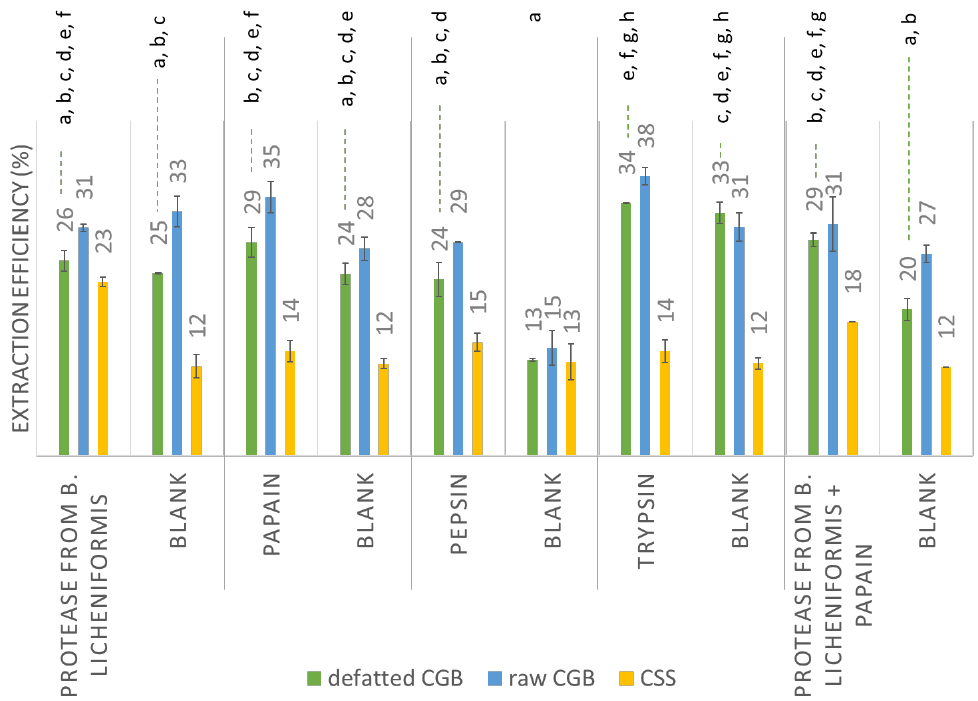
Figure 3. Extraction efficiency of aqueous extraction (blank) and enzyme-assisted extraction on coffee by-products. The extraction efficiency of the water extraction was measured under the same pH and temperature conditions of the respective EAE. The same letter means statistically equal values ( p < 0.05, Kruskal–Wallis test with independent samples) among the defatted CGB extraction efficiencies. No significant differences were found for raw CGB or CSS. The pH and temperature for each extraction were: Bacillus licheniformis protease pH 6.5–8.5, T 60 ◦ C; trypsin pH 7–9, T 37 ◦ C; pepsin pH 2–4, T 37 ◦